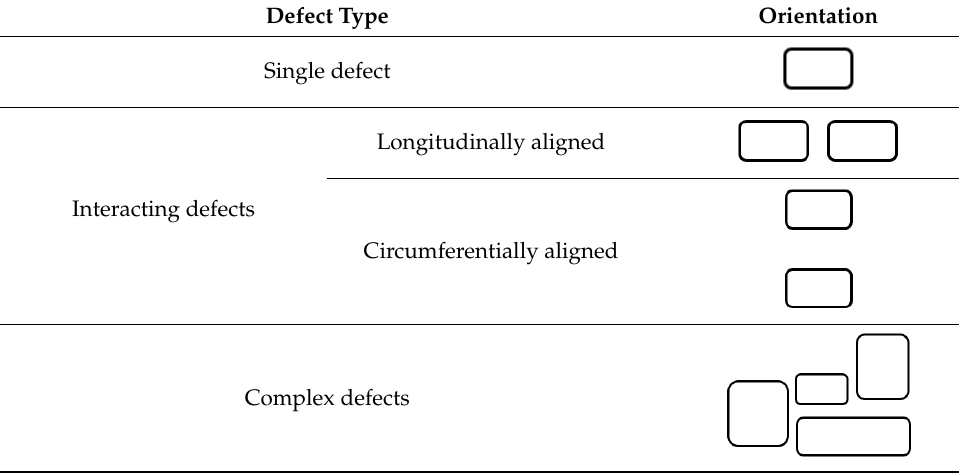
Table 1. Classification of defects [12].